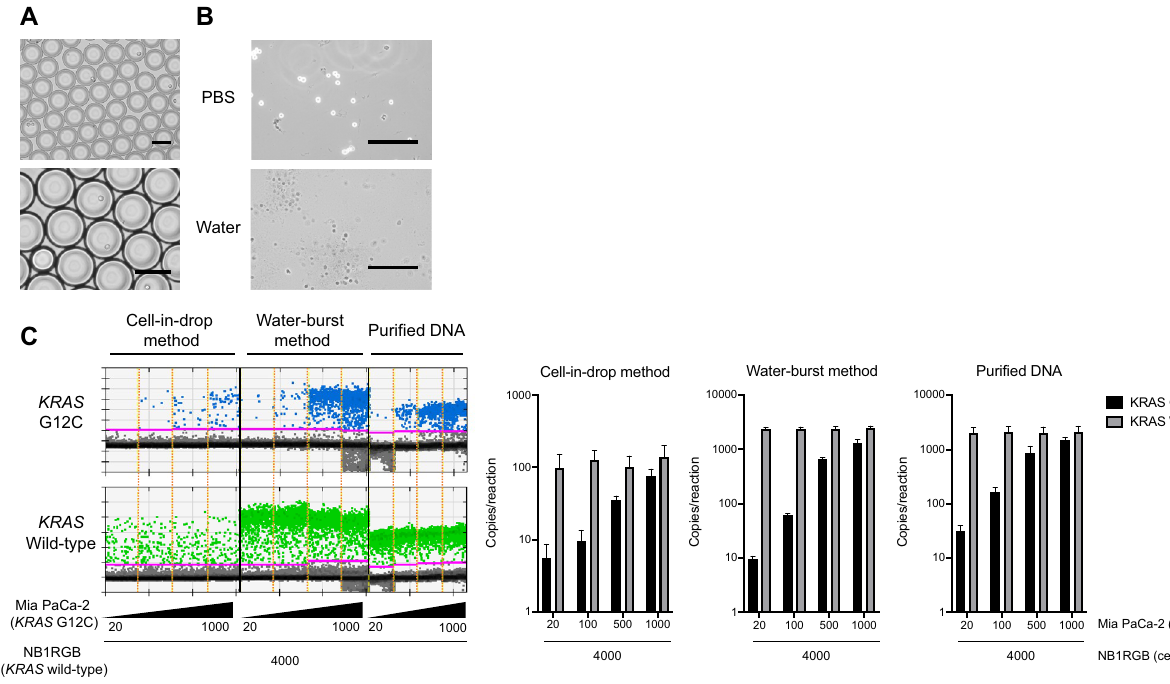
Figure 1. Experimental results using cell lines to improve the dPCR method for the highly sensitive mutation analysis of simple prepared samples. ( A ) Encapsulated cells in dPCR droplets. Cells were collected, resuspended in dPCR reaction solution, and mixed with droplet generation oil using the QX200 droplet generator. Scale bars; 200 μm. ( B ) Cells were burst using pure water. Cells were collected and resuspended in nuclease-free water, which caused an osmotic burst of cells, and genomic DNA was released into the water. The “crude” solution, including gDNA, was used as the dPCR template. Scale bars; 500 μm. ( C ) The DPCR assay was performed using the two novel DNA preparation methods, without a purification step. KRAS wild-type (Fibroblast; NB1RGB) and KRAS G12C (PDA; MIA PaCa-2) cells were mixed with several dilution series ( left panel ). The wild-type or G12C mutation in KRAS was detected using the QX200 droplet reader, as compared to the conventional DNA preparation method using commercial purification kits (see details in “Methods”). The KRAS copy number of wild-type or G12C measured by QuantaSoft software ( right panel